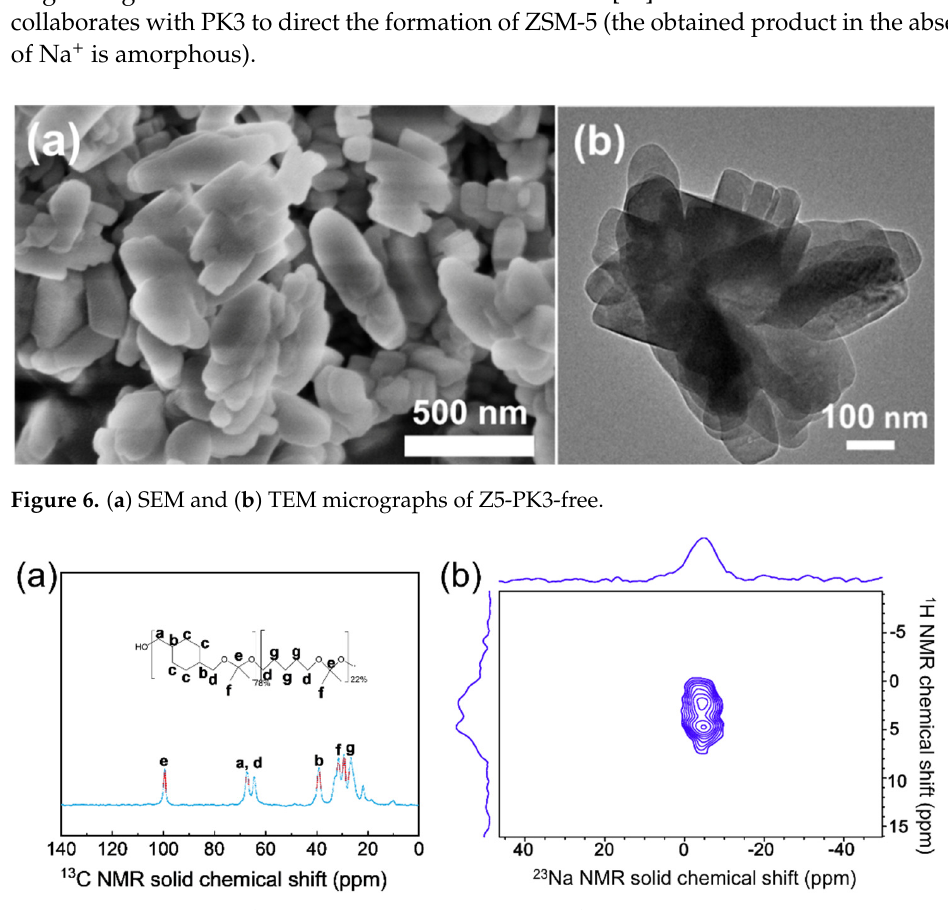
Figure 7. Solid–state ( a ) 13 C MAS NMR and ( b ) 2D 23 Na { 1 H} HETCOR NMR spectra of Na-Z5-PK3.